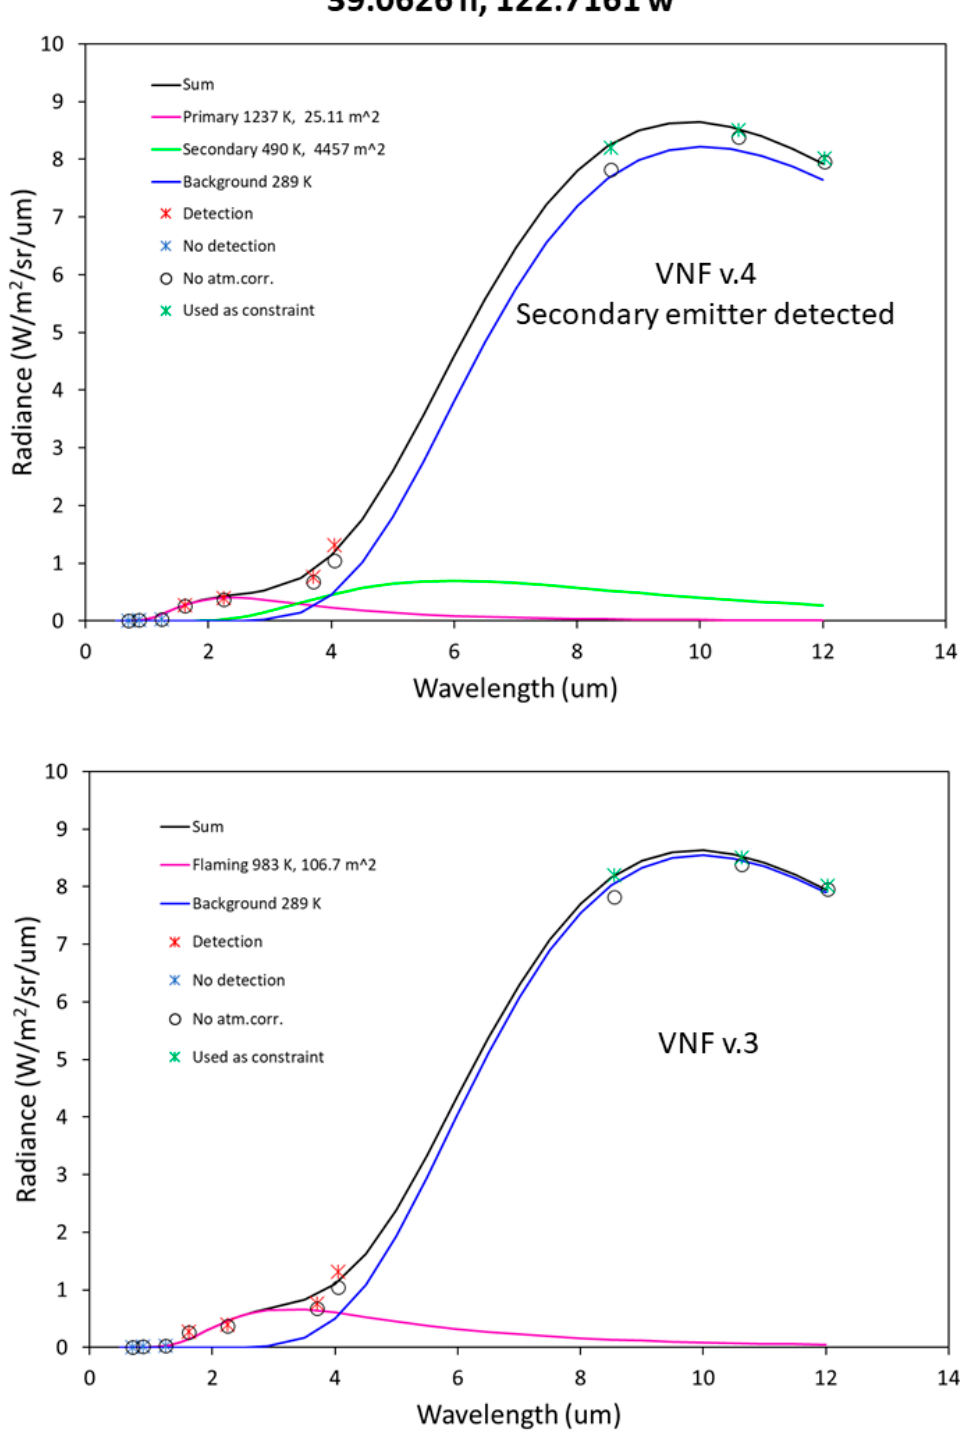
Figure 10. Spectral diagrams of a Type 4 pixel from the Mendocino Fire where a secondary IR emitter has been detected. Figure 11 shows a Mendocino Fire pixel with much higher radiances in the spectral bands. In fact, M12 has subpixel saturation and has been excluded from Planck curve fitting in both V.3 and V.4. The V. 3 processing resulted in a primary emitter temperature of 894 K and source size of 2297 m 2 . Splitting the radiant emissions with the flaming